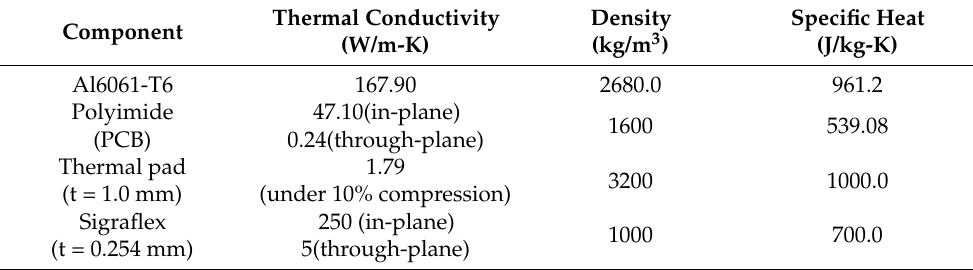
Table 1. Material and thermo-optical properties applied to the thermal analysis of